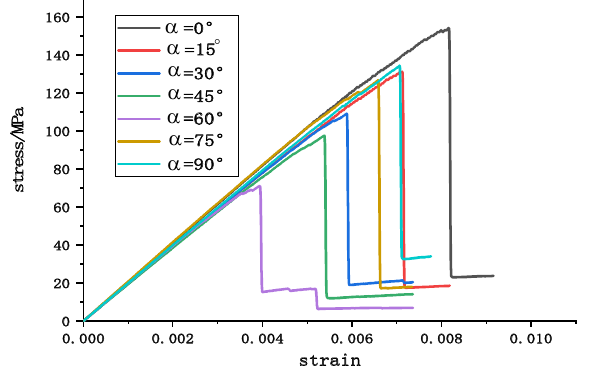
Figure 21. Stress–strain curves of phyllite under different bedding dips.